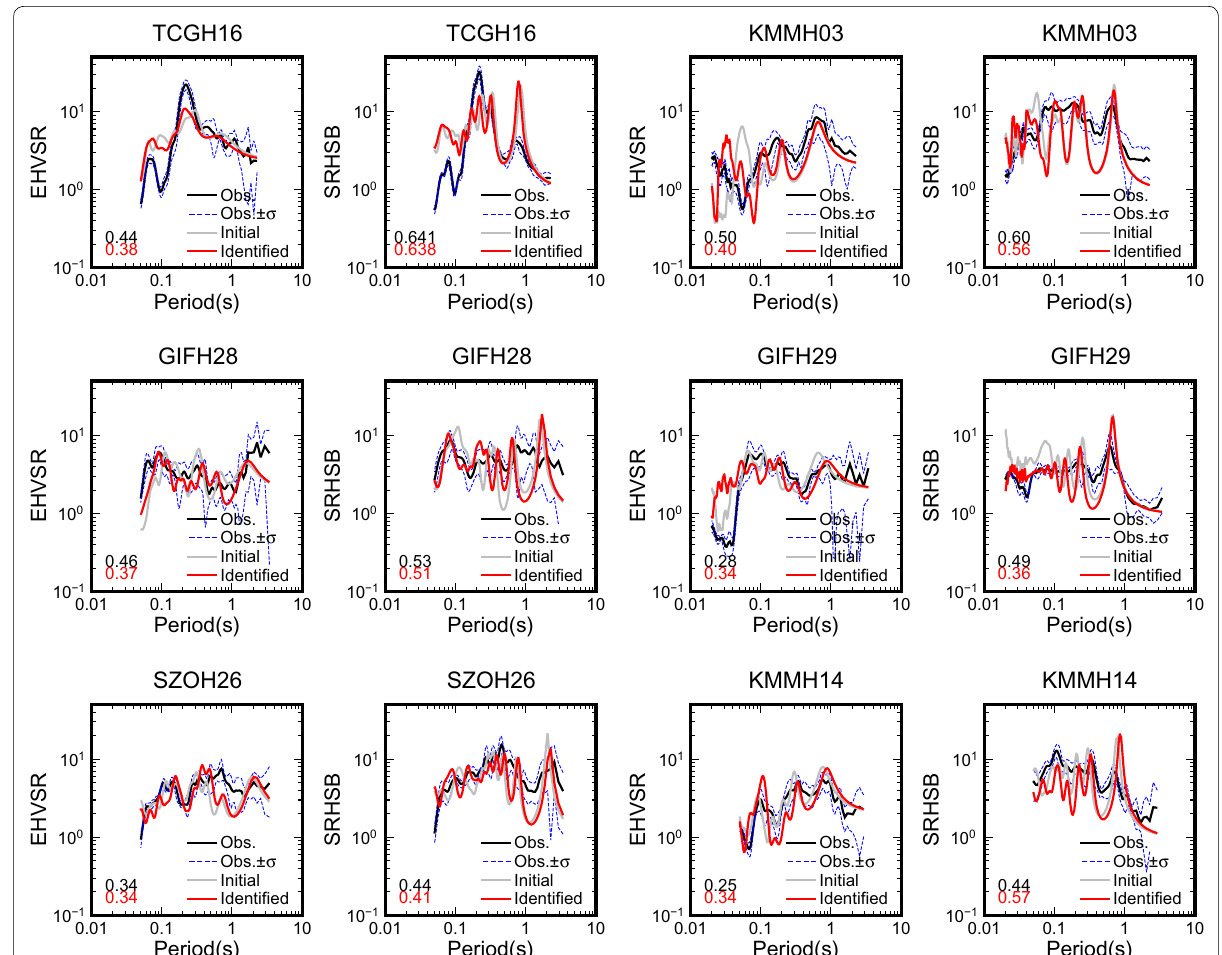
Fig. 10 Comparison between observed and theoretical EHVSRs, and between observed and theoretical SRHSBs at six KiK‑net strong‑motion stations. In the panels of EHVSRs, black curves denote the observed EHVSRs, dashed blue curves denote the observed EHVSRs with a standard deviation, gray curves denote the EHVSRs evaluated with the initial underground velocity structures, and red curves denote the EHVSRs evaluated with the identified underground velocity structures from surface to half‑space without cap layer. In the panels of SRHSBs, black curves denote the observed SRHSBs, dashed blue curves denote the observed SRHSBs within one standard deviation, gray curves denote the SRHSBs evaluated with the initial underground velocity structures from surface to bottom of boreholes, and red curves denote the SRHSBs evaluated with the under‑ ground velocity structures from surface to bottom of boreholes identified from SW H / V s. The numerical values in black represent the objective function Em between observed and theoretical EHVSRs (or SRHSBs) evaluated with initial underground velocity structures, and the numerical values in red represent the objective function Em between observed and theoretical EHVSRs (or SRHSBs) evaluated with identified underground velocity